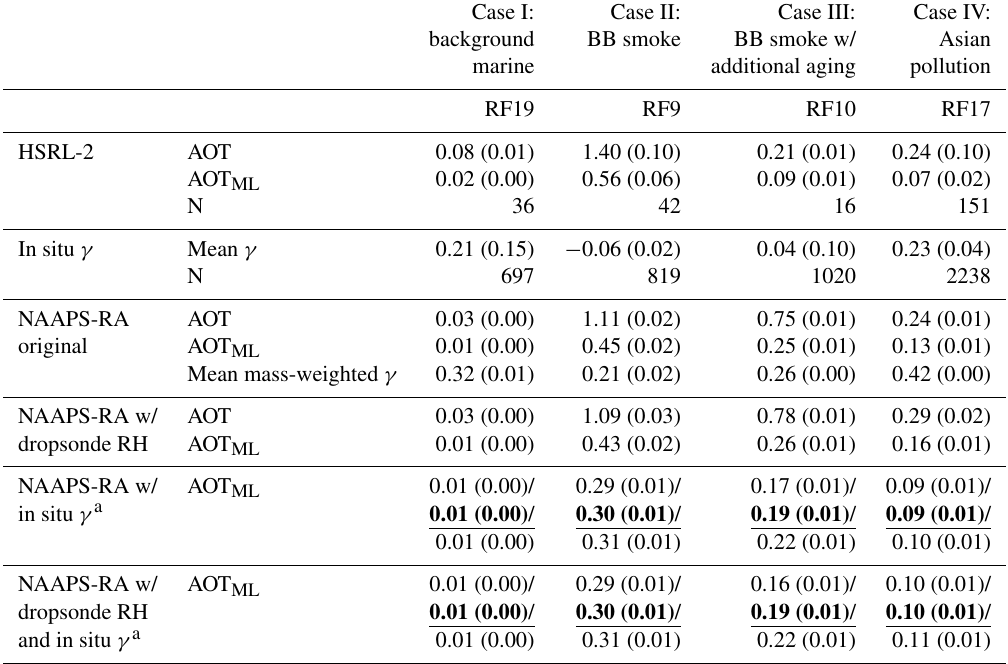
Table 3. Optical properties and summary statistics (means with standard deviations in parentheses) for NAAPS-RA/HSRL-2 comparisons for each case study. AOTML denotes AOT within the mixed layer (ML). Each case study is representative of a single 1 ◦ × 1 ◦ grid cell that was sampled during the flight indicated. “ N ” represents the number of data points. “BB” stands for biomass burning. The last two rows of the table report three sets of values where the first, second, and third sets are based on calculations using the γ value 1 standard deviation below the mean, the mean, and 1 standard deviation above the mean, respectively. Values calculated with the mean γ value are underlined and in bold